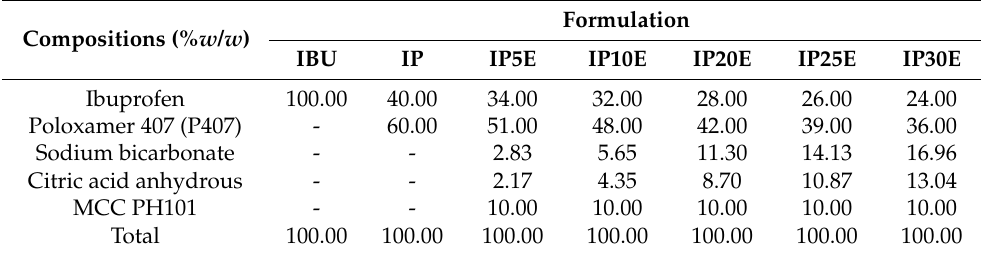
Table 1. Composition of eutectic effervescent